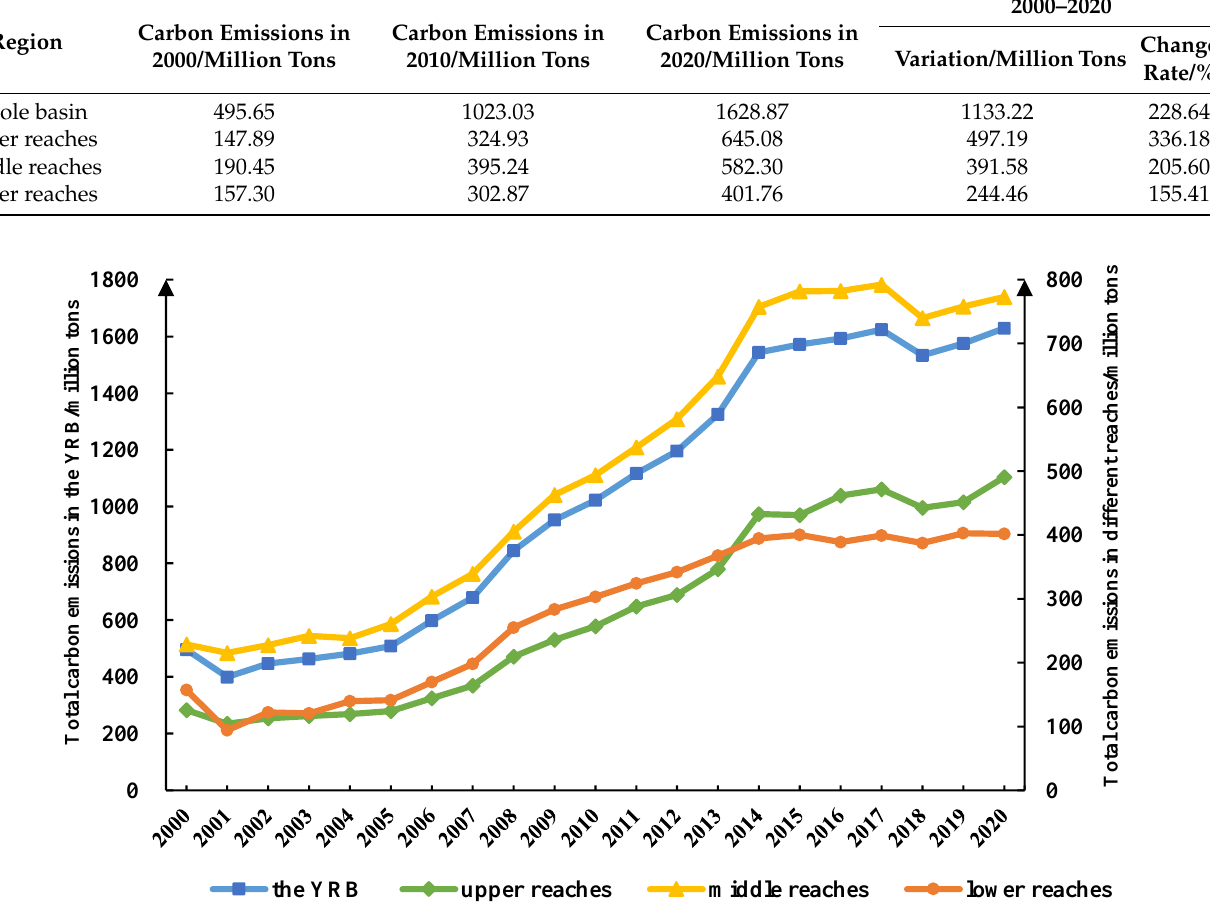
Figure 3. Trends of carbon emissions in the YRB during 2000 – 2020.